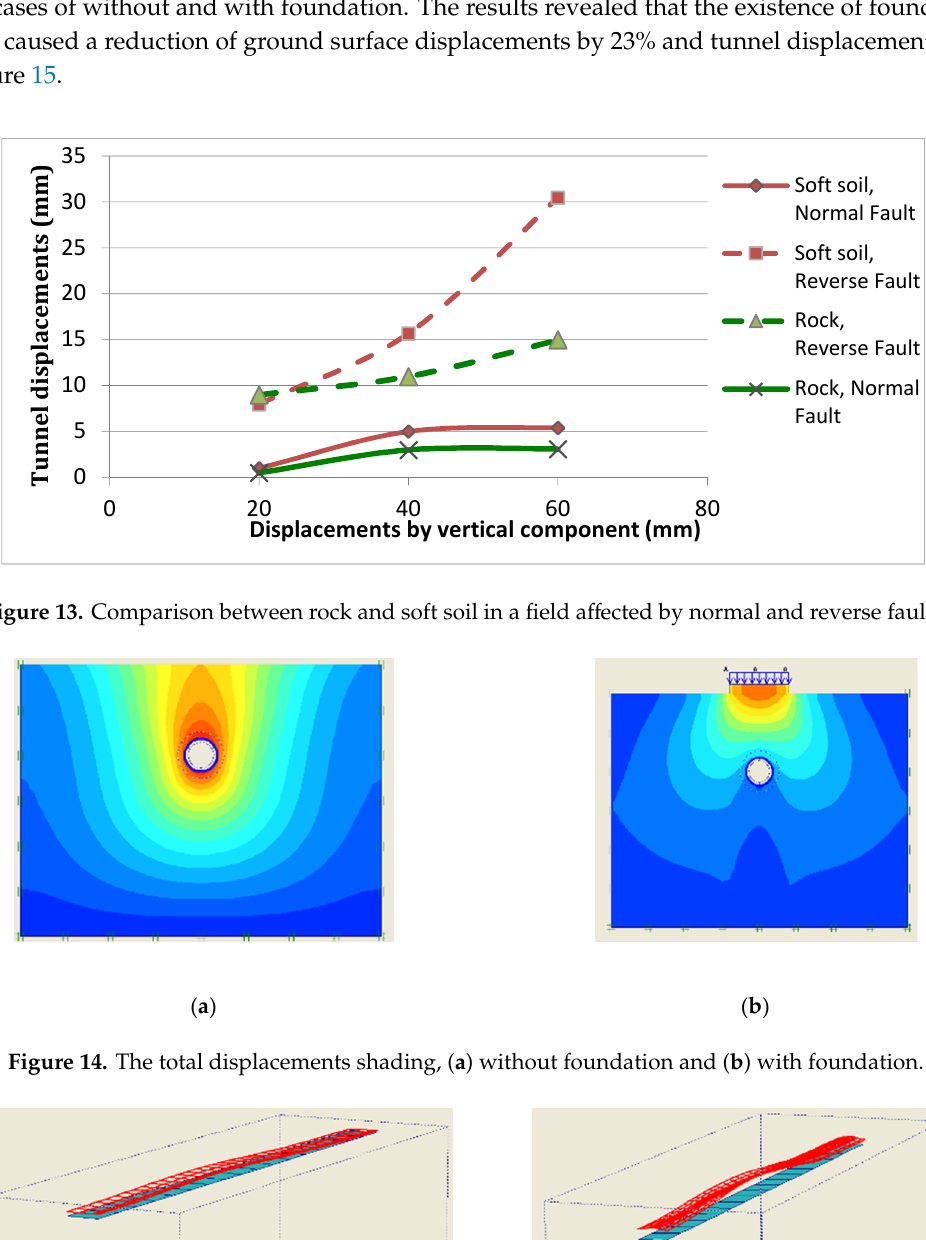
( c ) Figure 12. Failure when normal fault happens: ( a ) schematic diagram, ( b ) displacements, and ( c ) tunnel failure. 3.4. Finite Element Analysis The comparison between rock and soft soil under normal and reverse fault conditions showed that soft soil could cause two times more displacements than rock, and a comparison between normal and reverse faults showed that the displacements caused by reverse faults could be more than four times those caused by normal faults, see Figure 13. In addition, both soft soil and rock have been used in PLAXIS software for displacements comparisons when foundation is added to the field with a tunnel. The displacements changed when foundation was added to the field, compared to without foundation when all stresses focused on the tunnel itself. Hence, foundation reduced the settlements of the tunnel. Figure 14 shows the differences in the total displacements obtained from the analyses